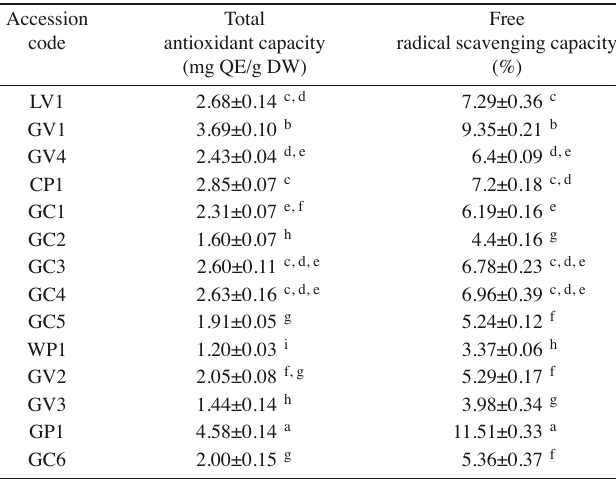
Tab. 5: Antioxidant activity of fruits from Solanum anguivi Lam. accessions.